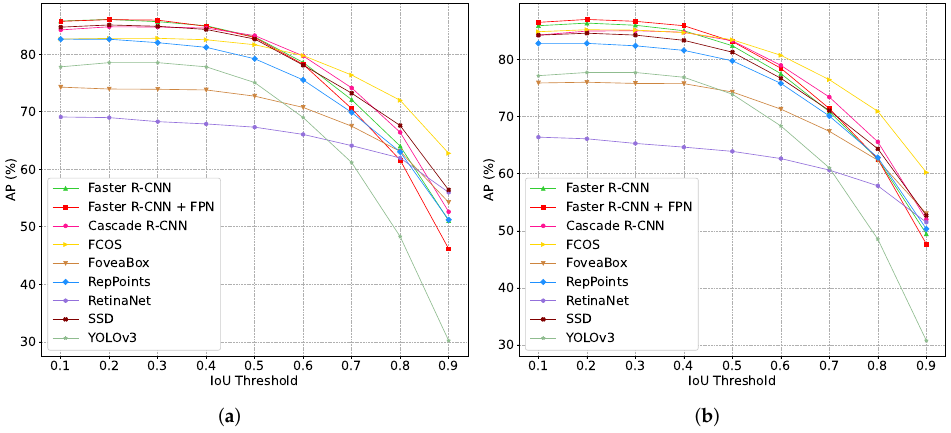
Figure 6. Variation of Average precision (AP) for nine CNN models with the IoU threshold on the validation ( a ) and test ( b )